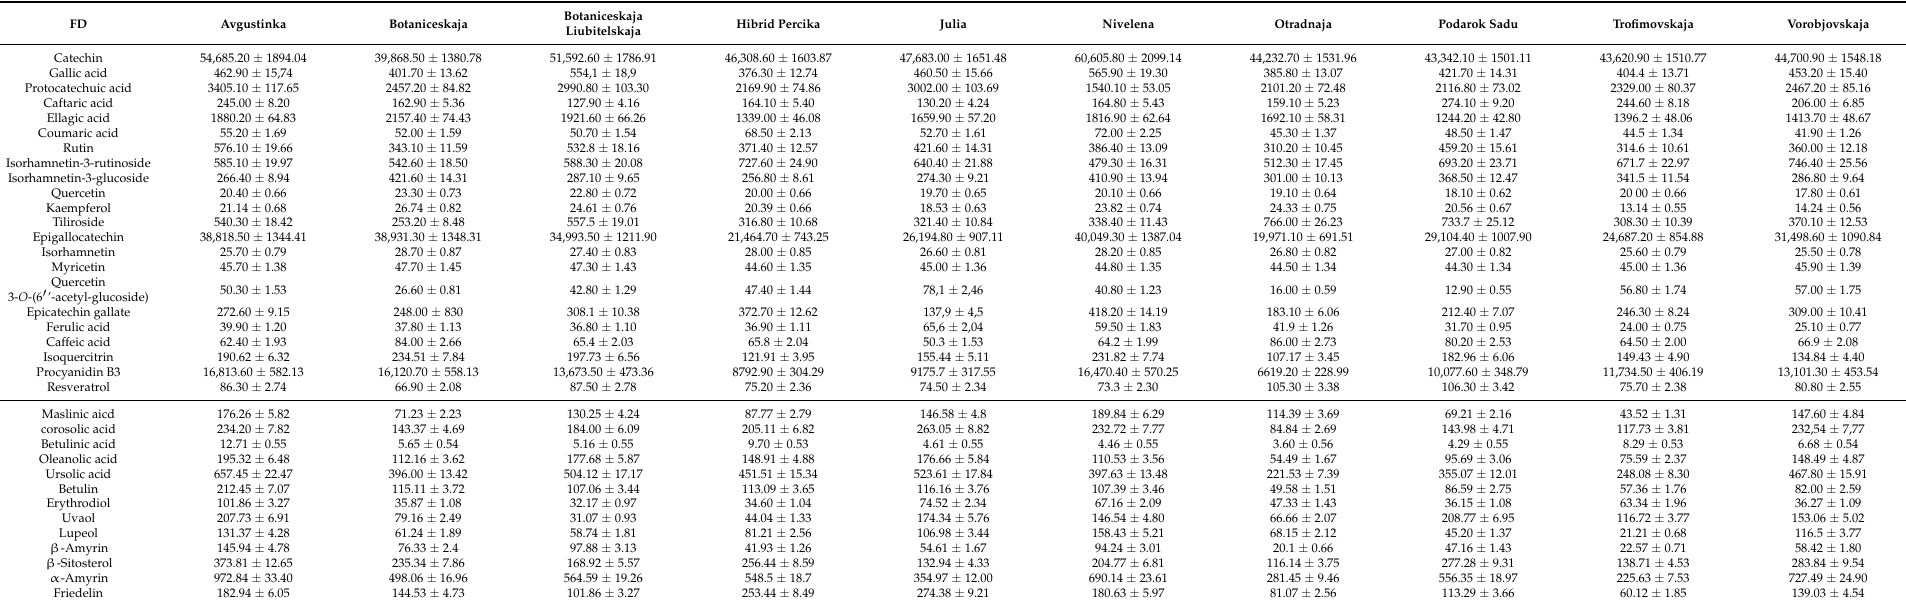
Table 2. Phenolic and triterpenic profiles ( µ g/g, dw) of freeze-dried Hippophae rhamnoides cultivars’ leaf